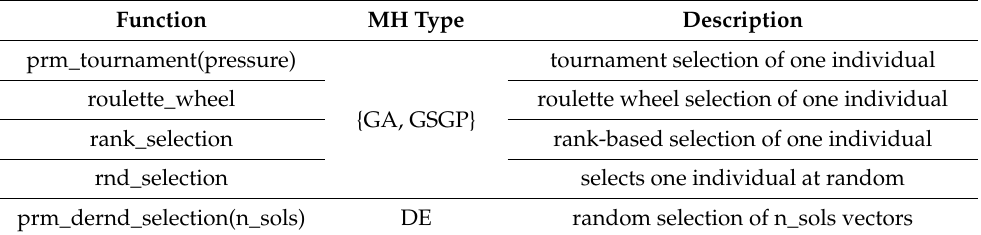
Table 2. Descriptions of the selectors